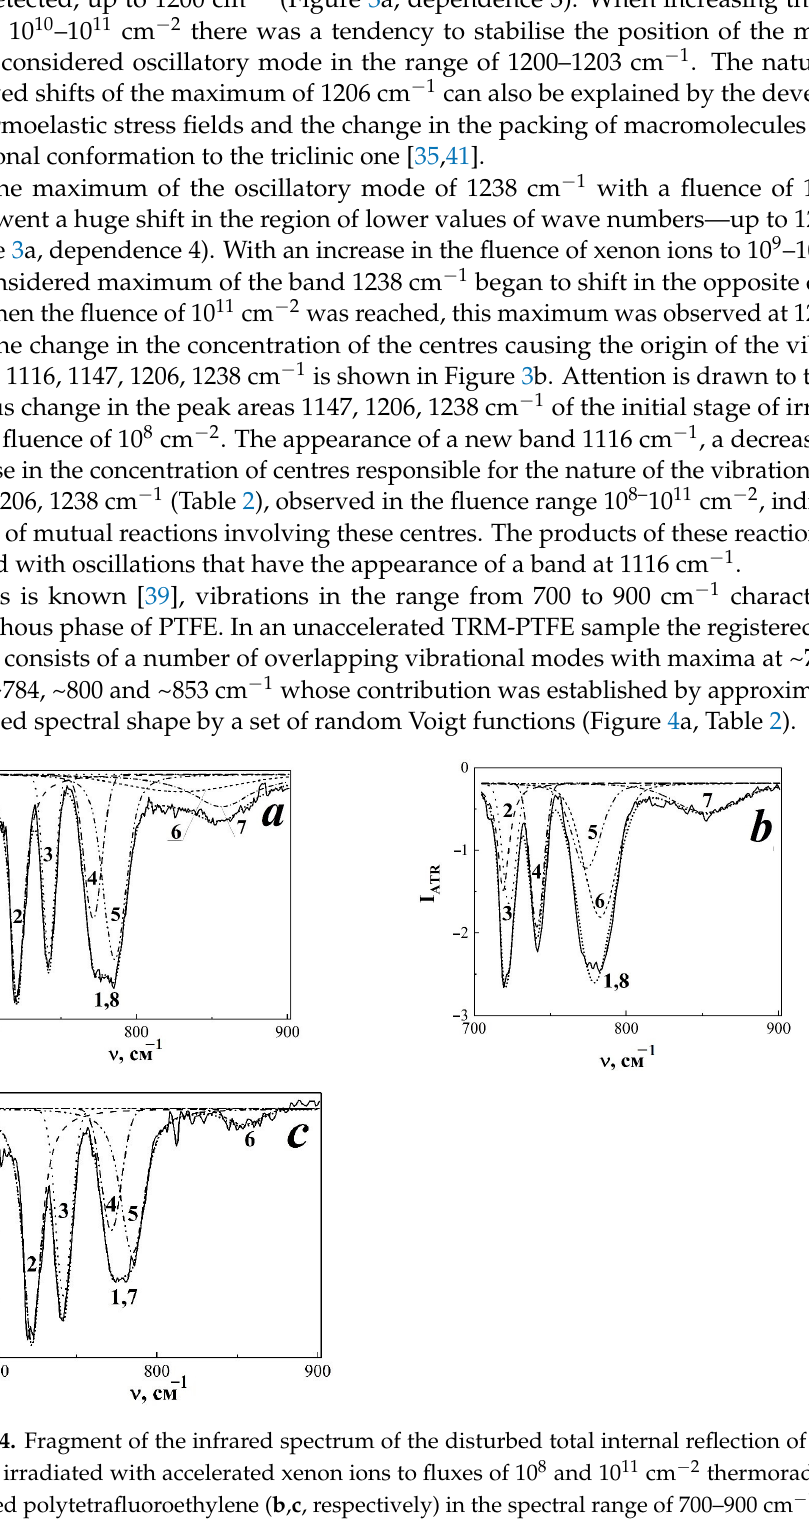
Figure 3. Change in the position of maxima ( a ) and peak areas ( b ) of oscillatory modes 1116 (1), 1147 (2), 1206 (3), 1238 (4) cm − 1 in the infrared spectra of the disturbed total internal reflection of ther- moradiationally modified polytetrafluoroethylene depending on the fluence of xenon ions with an energy of ~1 MeV/nucleon.